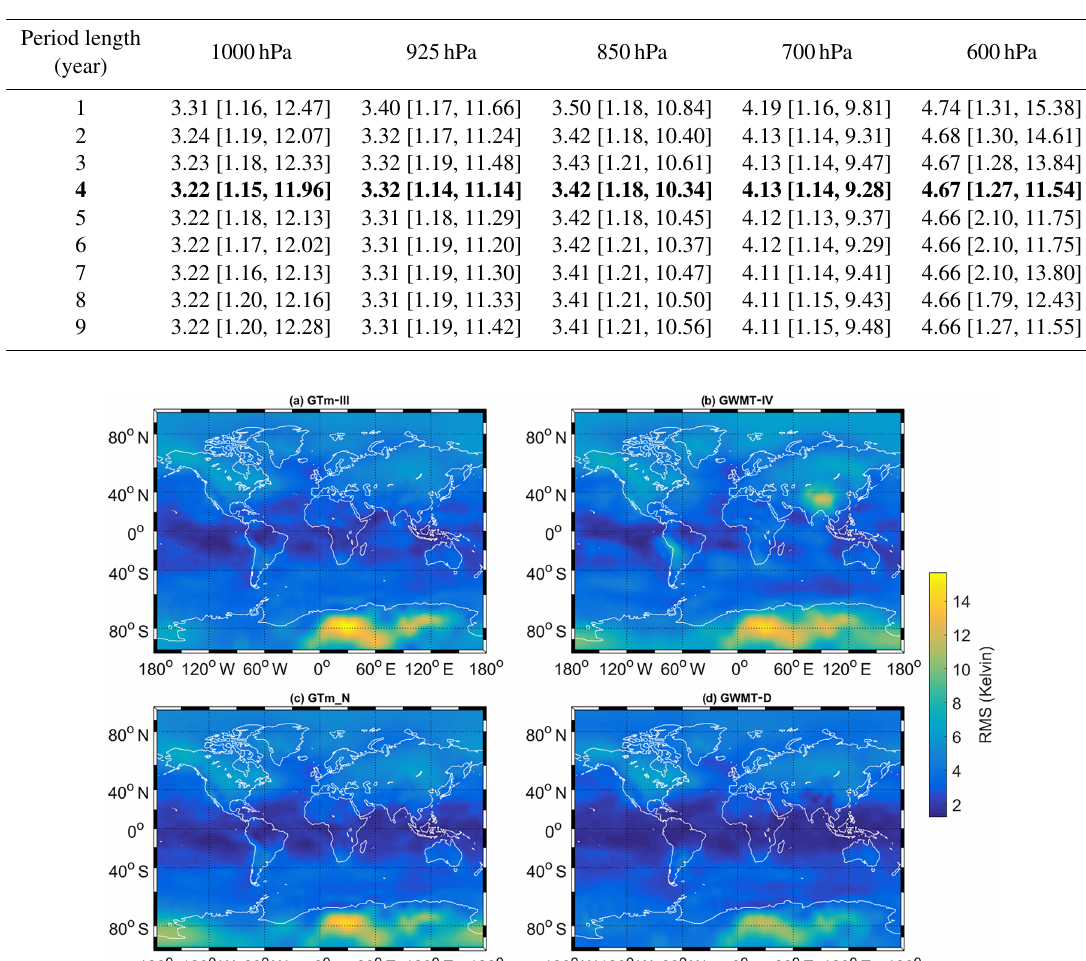
Table 2. The global mean RMSE of various GWMT–D models built with different lengths of time periods (2005–2013) of NCEP2 data at five pressure levels (in K). The reference T m are derived from NCEP2 data in 2014. The values inside square brackets are the minimum and maximum, and the fourth row (in bold) shows the best fitting results.